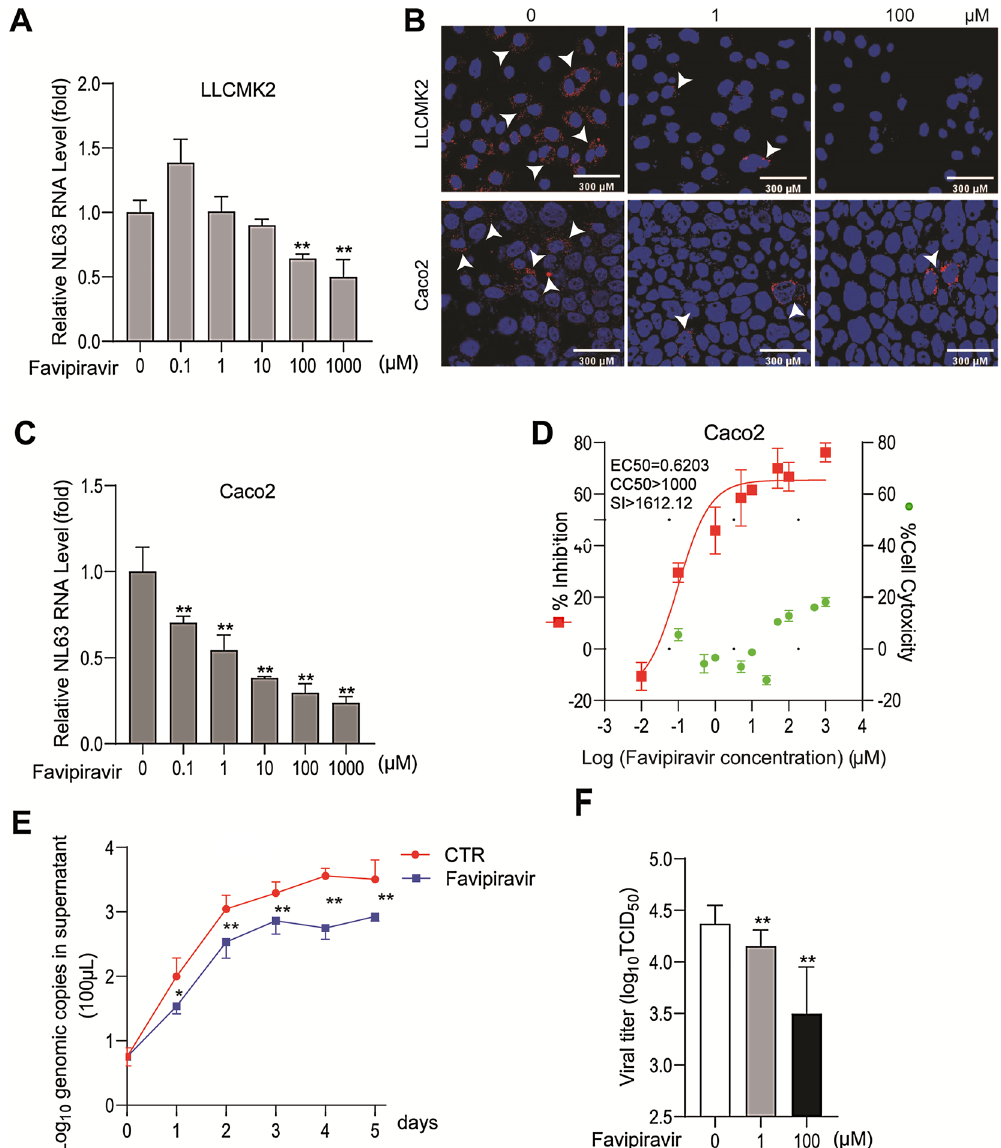
Figure 4. Antiviral effects of favipiravir against HCoV-NL63 in cell culture models. ( A ) Dose-dependent inhibition of HCoV-NL63 replication in LLC-MK2 cell line by favipiravir treatment. Intracellular viral RNA quantified by qRT-PCR was normalized to housekeeping gene GAPDH and presented relative to the control (CTR) (set as 1) (n = 6). ( B ) Immunofluorescence microscopy analysis of dsRNA, the intermediate of replicating HCoV-NL63 genomic RNA, upon treatment of different concentrations of favipiravir in LLC-MK2 and Caco-2 cell lines. Nuclei were visualized by DAPI (blue). ( C ) Dose-dependent inhibition of HCoV-NL63 replication by favipiravir in Caco-2 cell line (n = 6). ( D ) Caco-2 cells were infected with 0.1 MOI HCoV-NL63 and treated with different concentrations of favipiravir for 48 h. 50% effective concentration (EC50) curve was quantified by qRT- PCR, and 50% cytotoxic concentration (CC50) curve was determined by MTT assay. The left and right Y-axis of the graphs represent mean % inhibition of virus yield and cytotoxicity of the drug, respectively (n = 6–8). ( E ) Caco-2 cells were infected with 0.1 MOI HCoV-NL63, and then untreated or treated with 10 μM favipiravir for 5 days. Supernatant was collected every day to quantify secreted viruses by qRT-PCR, calculated as genomic copy numbers (n = 6). Standard curve for calculation of genomic copy numbers is included in Supplementary Fig. S3. ( F ) Caco-2 cells were infected with 0.1 MOI HCoV-NL63, and then untreated or treated with 1 or 100 μM favipiravir for 48 h. Virus titers from different groups was determined by TCID50 assay (n = 6). Data represent as mean ± SD. * P < 0.05; ** P < 0.01; *** P <